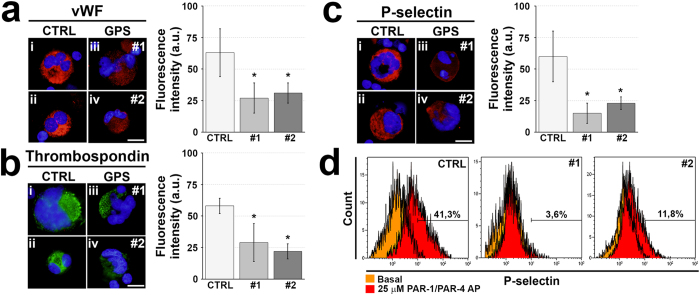
Lack of α-granule proteins in GPS cultured megakaryocytes.Fully differentiated megakaryocytes from healthy controls (CTRL) and patients with GPS were harvested and allowed to adhere onto Poly-L-Lysine coated cover-slips by centrifugation, fixed and analyzed. (a) Representative immunofluorescence staining of von Willebrand Factor (vWF) in CTRL- (i–ii) and GPS-derived megakaryocytes (iii–iv) (red = vWF; blue = nuclei; scale bar = 20 μm). Bars report the analysis of fluorescence intensity by Image J software (a.u. = arbitrary units). Data are presented as mean±SD (*p < 0.05). (b) Representative immunofluorescence staining of thrombospondin in CTRL- (i–ii) and GPS-derived megakaryocytes (iii–iv) (green = thrombospondin; blue = nuclei; scale bar = 20 μm). Bars report the analysis of fluorescence intensity by Image J software (a.u. = arbitrary units). Data are presented as mean ± SD (*p < 0.05). (c) Representative immunofluorescence staining of P-selectin in CTRL- (i–ii) and GPS-derived megakaryocytes (iii–iv) (red = P-selectin; blue = nuclei; scale bar = 20 μm). Bars report the analysis of fluorescence intensity by Image J software (a.u. =  arbitrary units). Data are presented as mean±SD (*p < 0.05). (d) Representative flow cytometry analysis of P-Selectin exposure by CTRL- and GPS-derived megakaryocytes in basal condition (orange) and upon stimulation with 25 μM PAR-1 and PAR-4 activating peptides (AP) (red). Bars highlight the increased percentage of P-Selectin+ megakaryocytes upon stimulation with respect to basal.